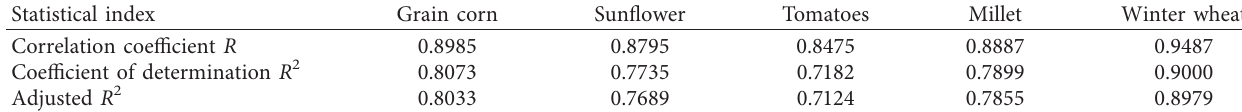
Table 1: Regression statistics for the FGCC model developed into NDVI conversion for the crops studied.